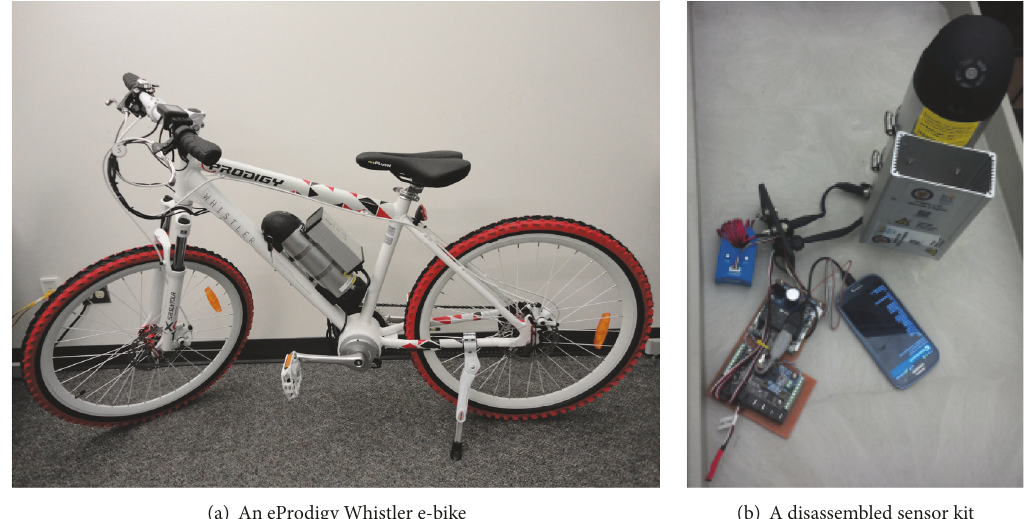
Figure 1: Illustration of the e-bikes and sensor kits used in the WeBike